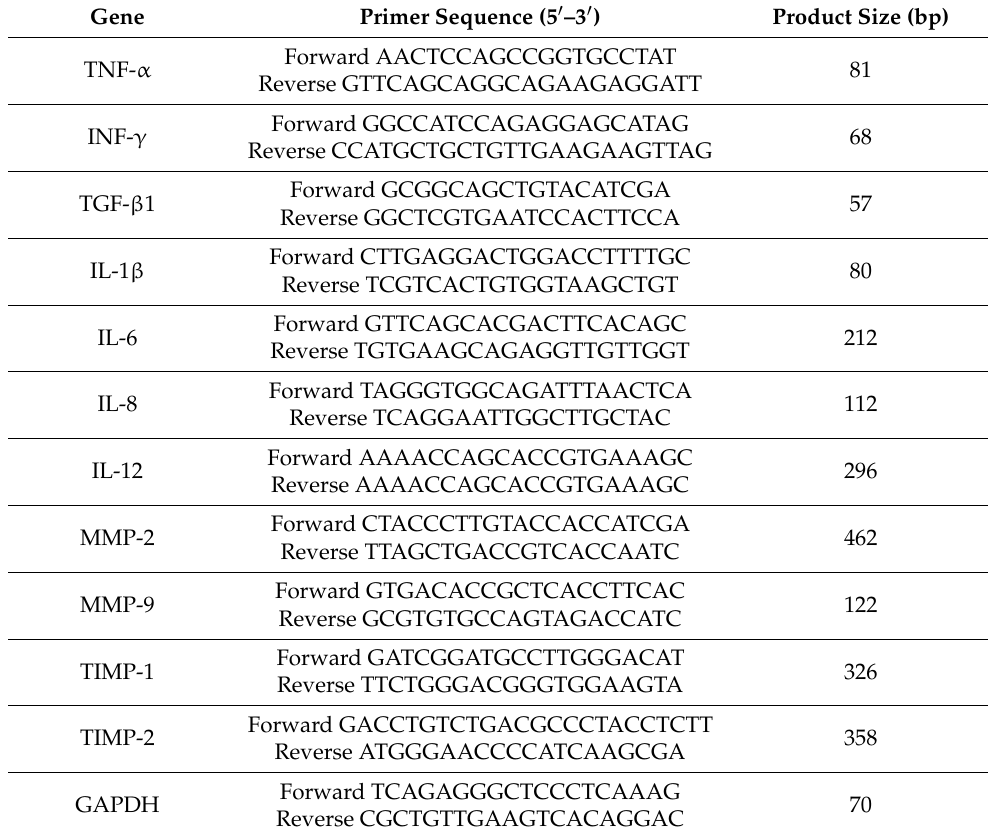
Table 1. List of primers for